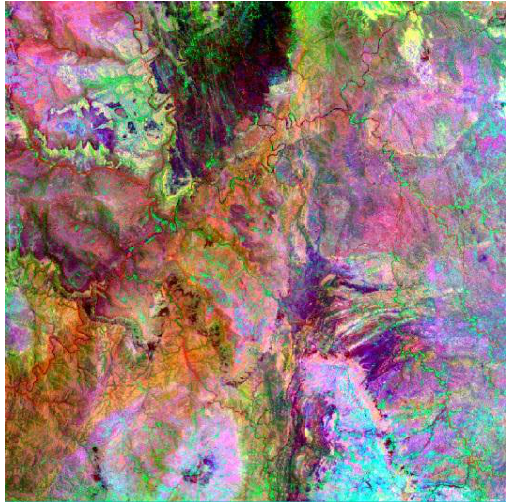
Fig 5. ICA band (1,5,7) Combination